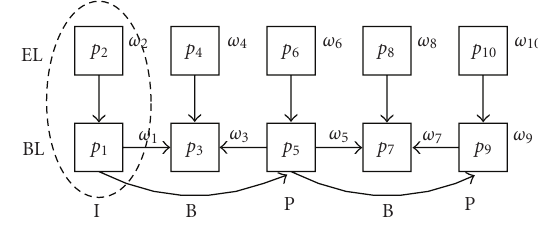
Figure 1: Video packets as a directed acyclic